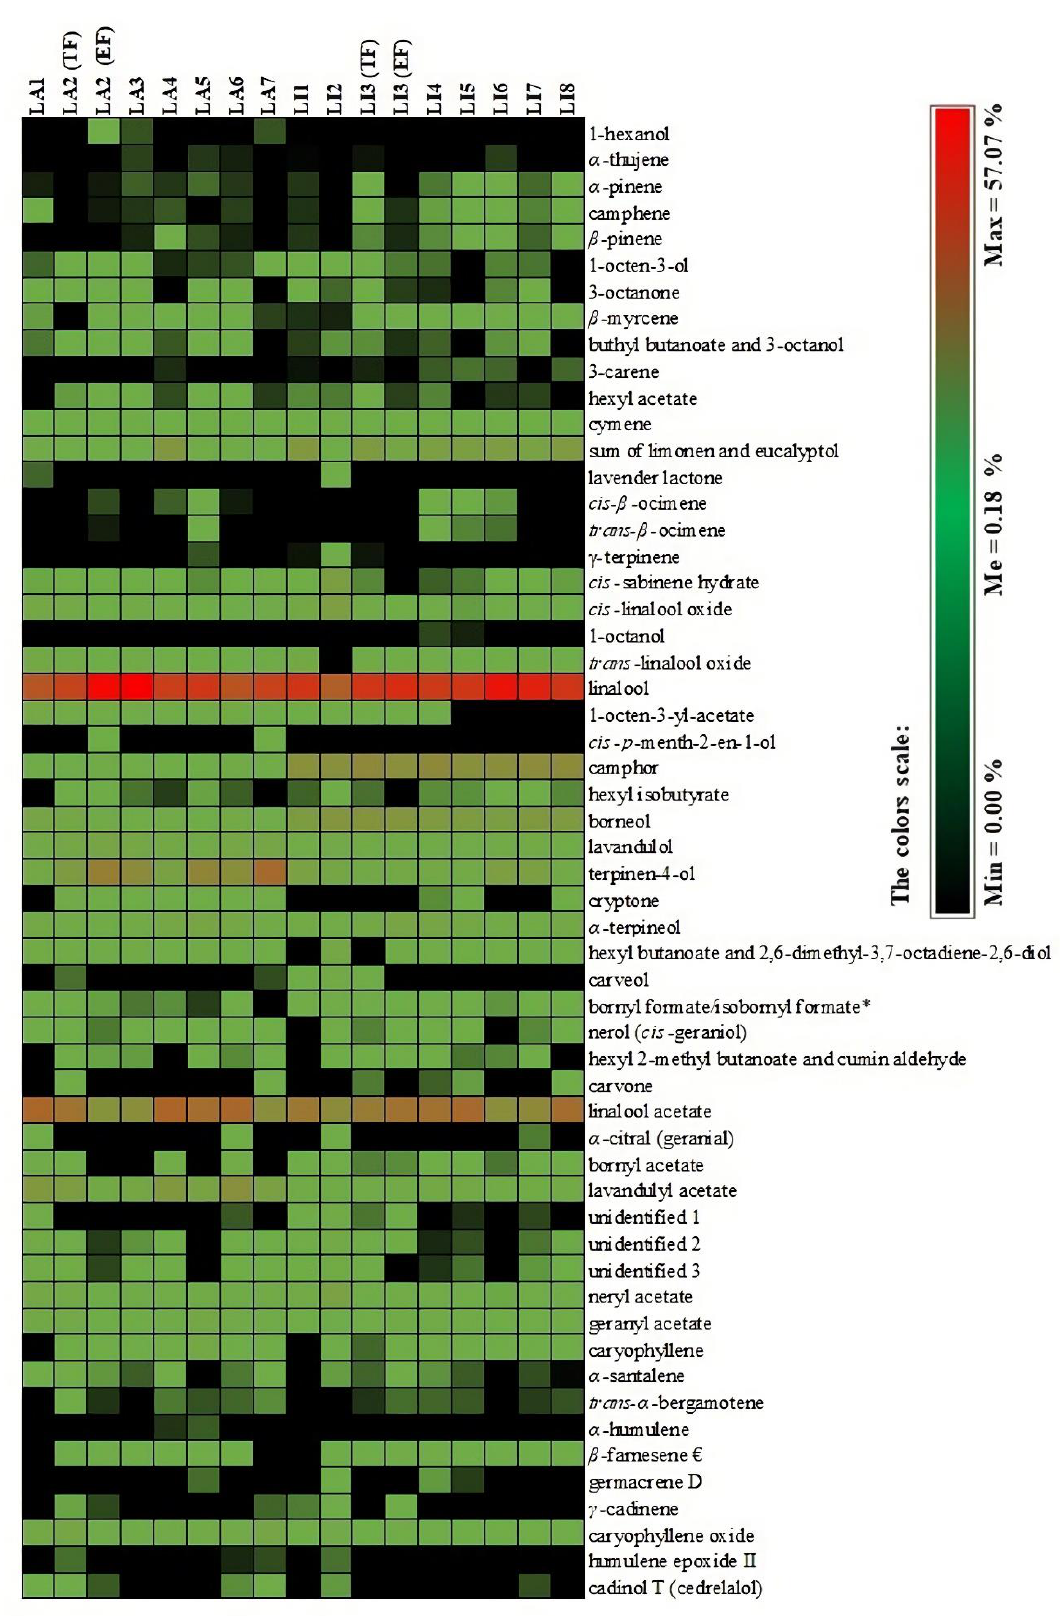
Figure 3. A heatmap of tested LA and LI essential oil samples based on the compounds identified with GC–MS. Black color indicates that the compound was not detected in the sample. * tentative